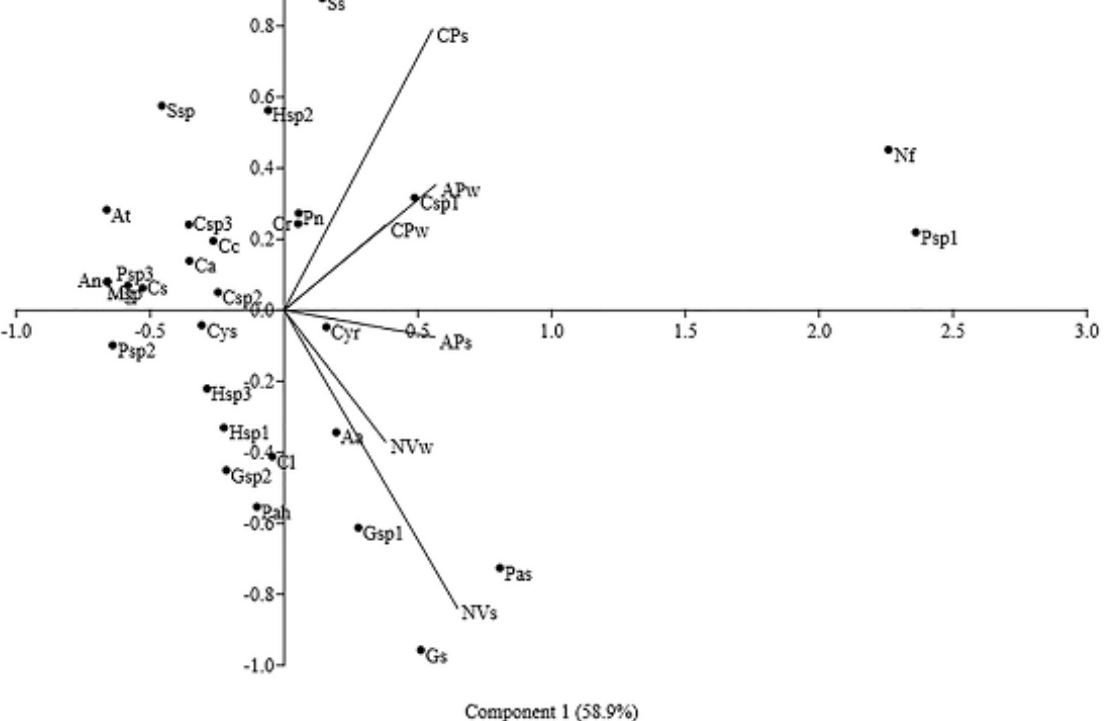
Figure 3. Association (principal component analysis) of ant species with three environments from rural properties located in Colônia São Manoel, Pelotas, RS, Brasil, (2017 – 2018). *APs: agroecological peach orchard (summer); APw: agroecological peach orchard (winter); CPs: conventional peach orchard (summer); CPw; conventional peach orchard (winter); NVs: native vegetation (summer); NVw: native vegetation (winter) **Gs: Gnamptogenys